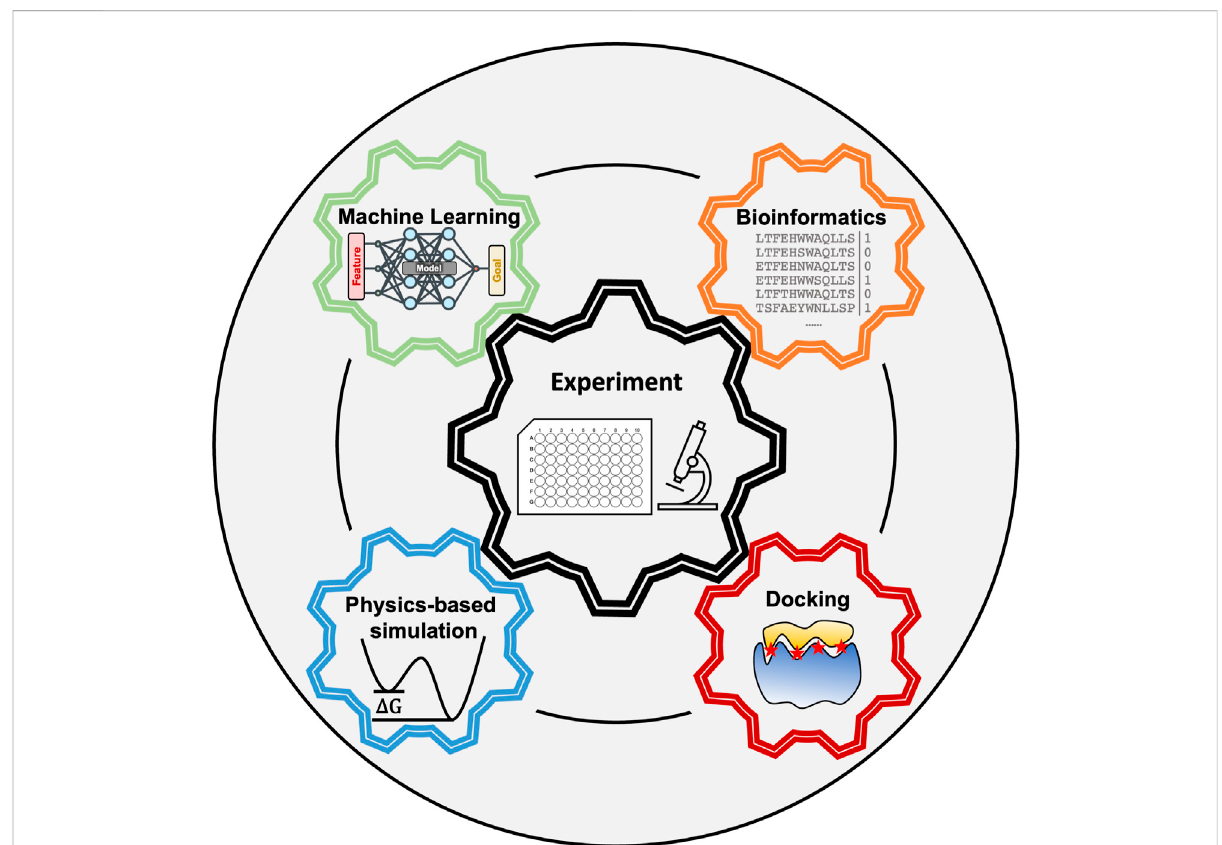
FIGURE 1 Peptide modeling requires synergy between multiple computational techniques and